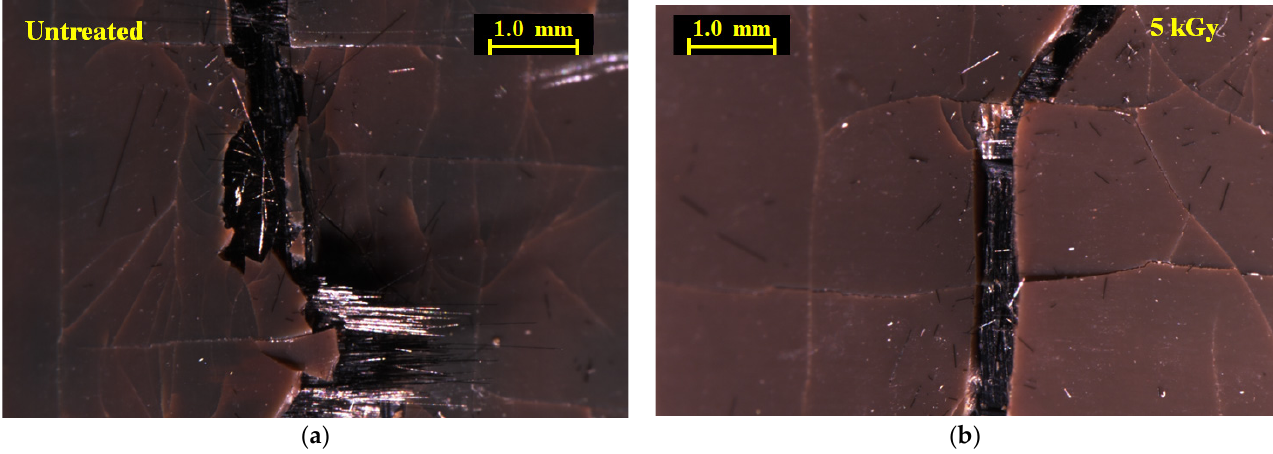
Figure 10. Optical microscope photos of tensile side of untreated ( a ) and 5 kGy ( b ) [PPS] 4 [CF] 3 samples, respectively, showing a close - up of the main crack.